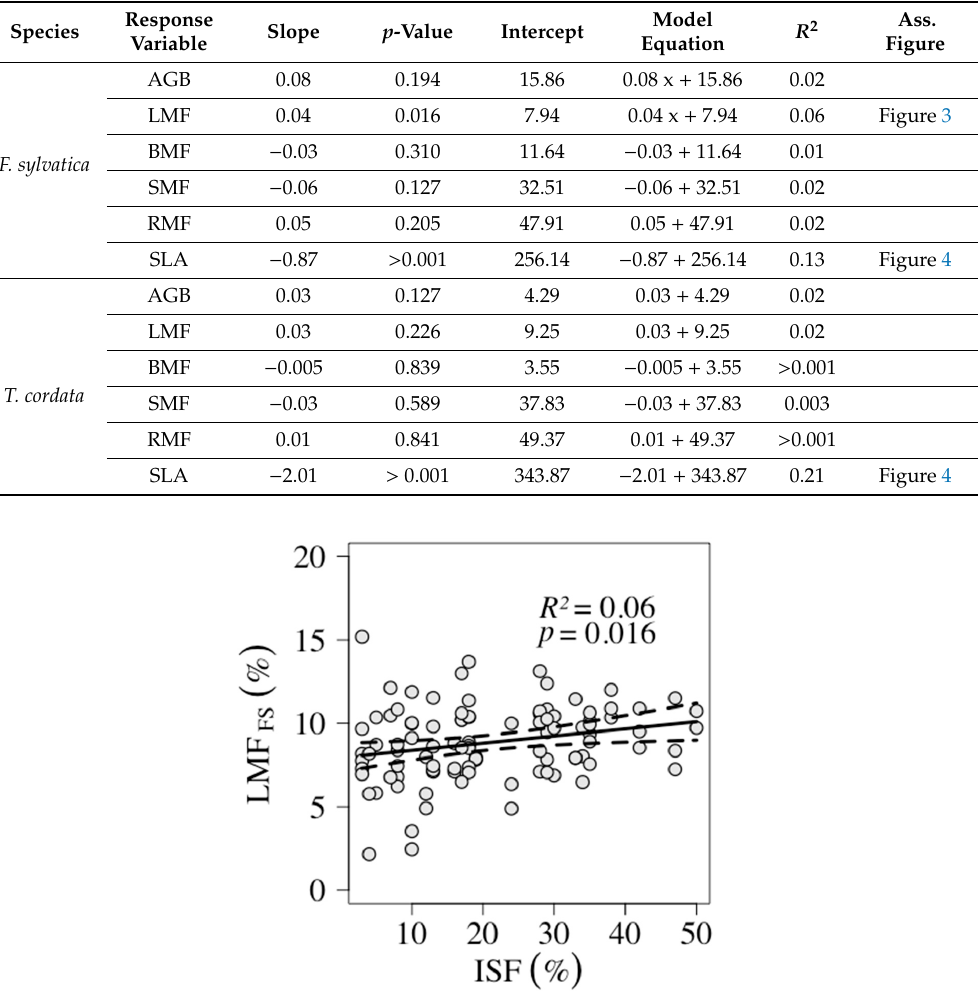
Table 3. Results from generalized linear models (GLM) for seedlings growth response analysis in